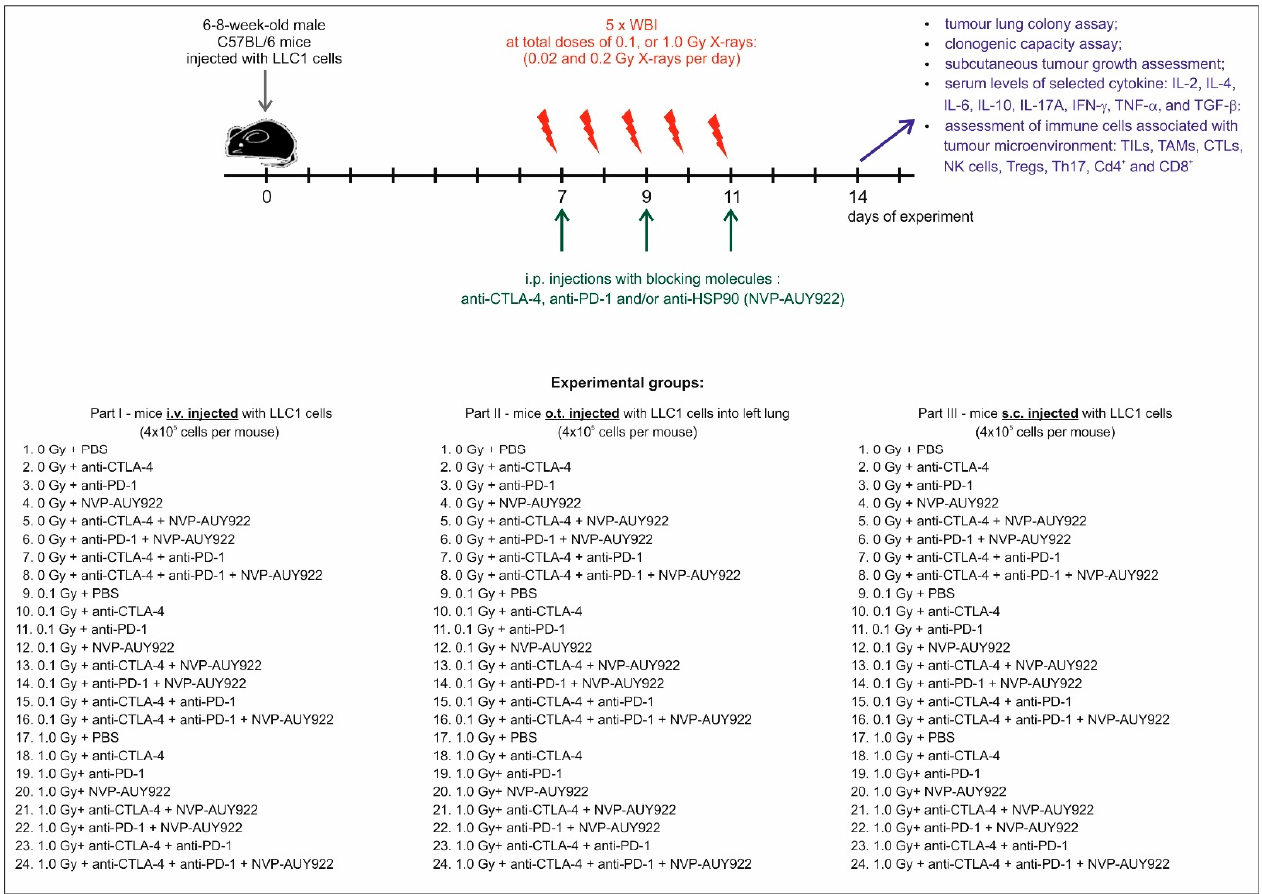
Figure 7. Experimental protocols.